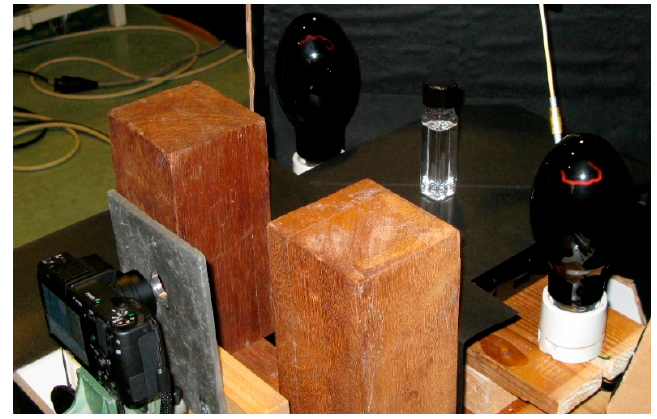
Figure 14. The set-up used to monitor, in situ, the fluorescence of an RFG gel on insertion of a seed of 192 Ir. The main constituents are a 20 × 20 mm 2 glass cell containing the gel into which a 1.9 mm diameter catheter (shown in Figure 15) is inserted via a septum cap; two mercury-arc UV (365 nm) lamps, a Ricoh GX200 digital camera with a lead shield against gamma irradiation and wooden shields against direct UV.